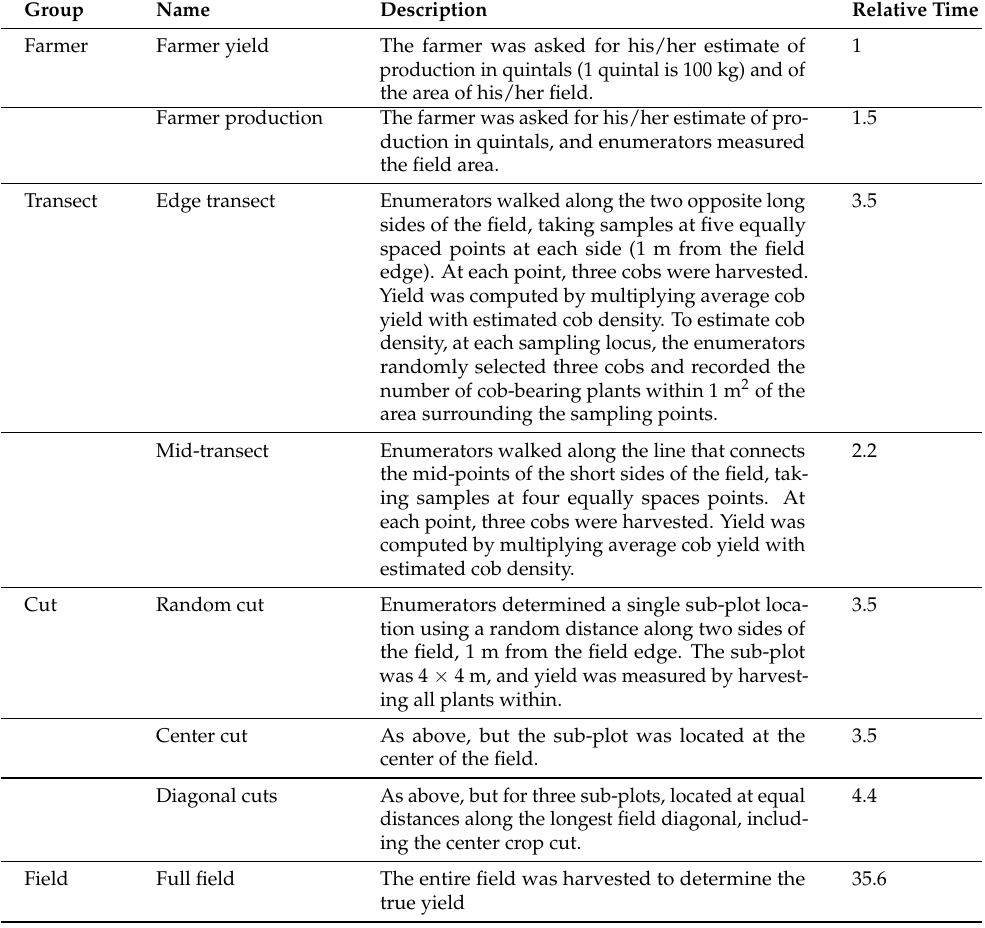
Table 1. Field sampling methods used to estimate and measure maize yield in fields in Ethiopia and relative time, i.e., the amount of time spent in the field to estimate yield, relative to the “farmer yield”